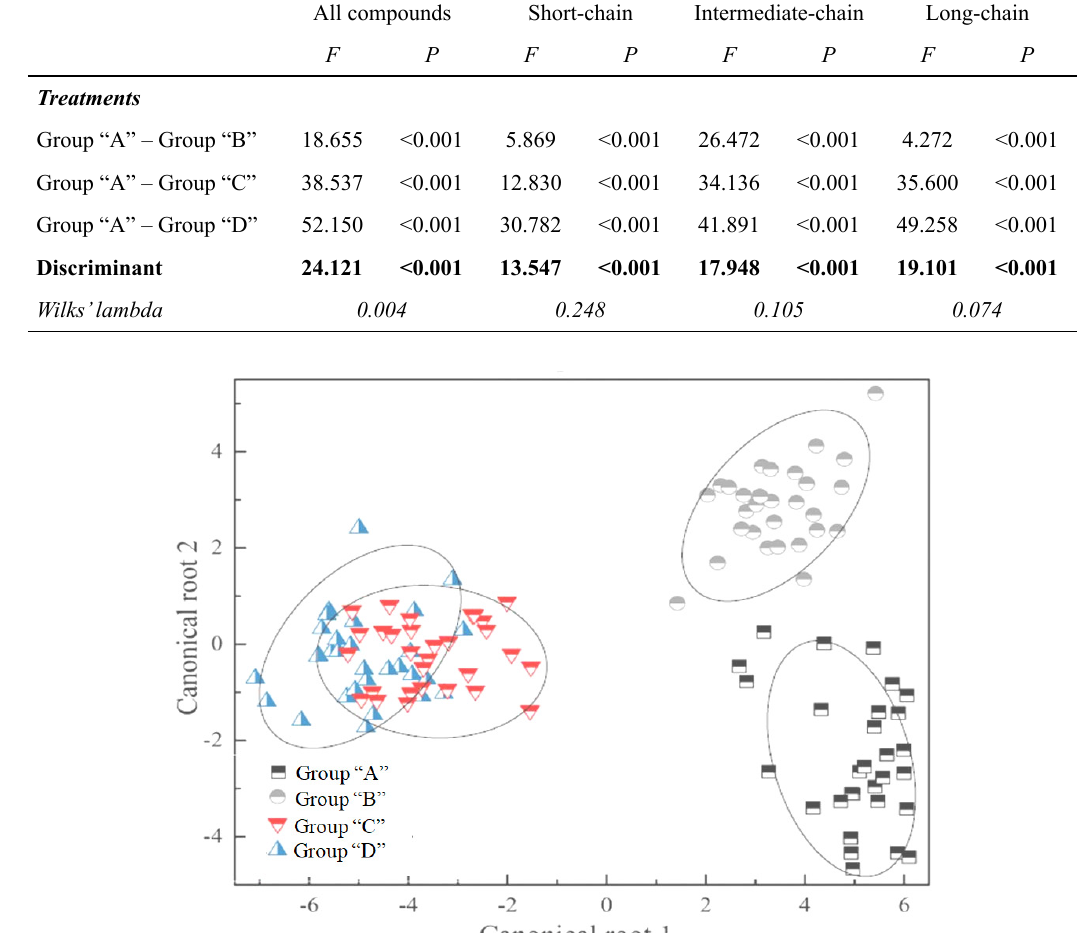
Fig 5. Scatter diagram obtained using the two canonical roots for differentiation of the compounds present in the cuticles of Odontomachus brunneus workers submitted to different treatments, based on the relative abundances (peak areas) of the cuticular